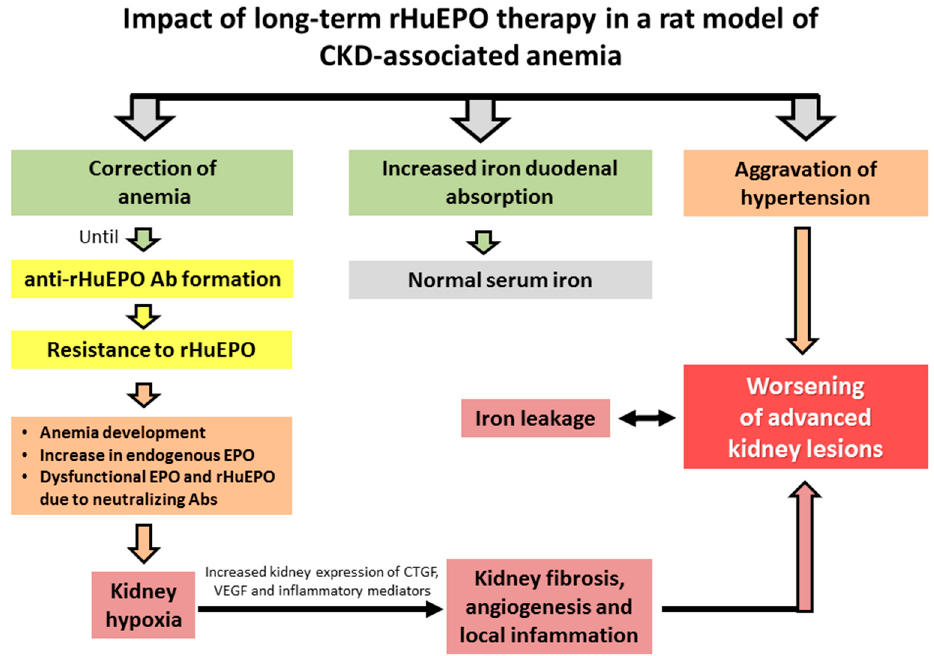
Figure 8. Proposed mechanisms for the impact of resistance to rHuEPO therapy due to anti-EPO antibodies formation in a rat model of CKD-associated anemia.